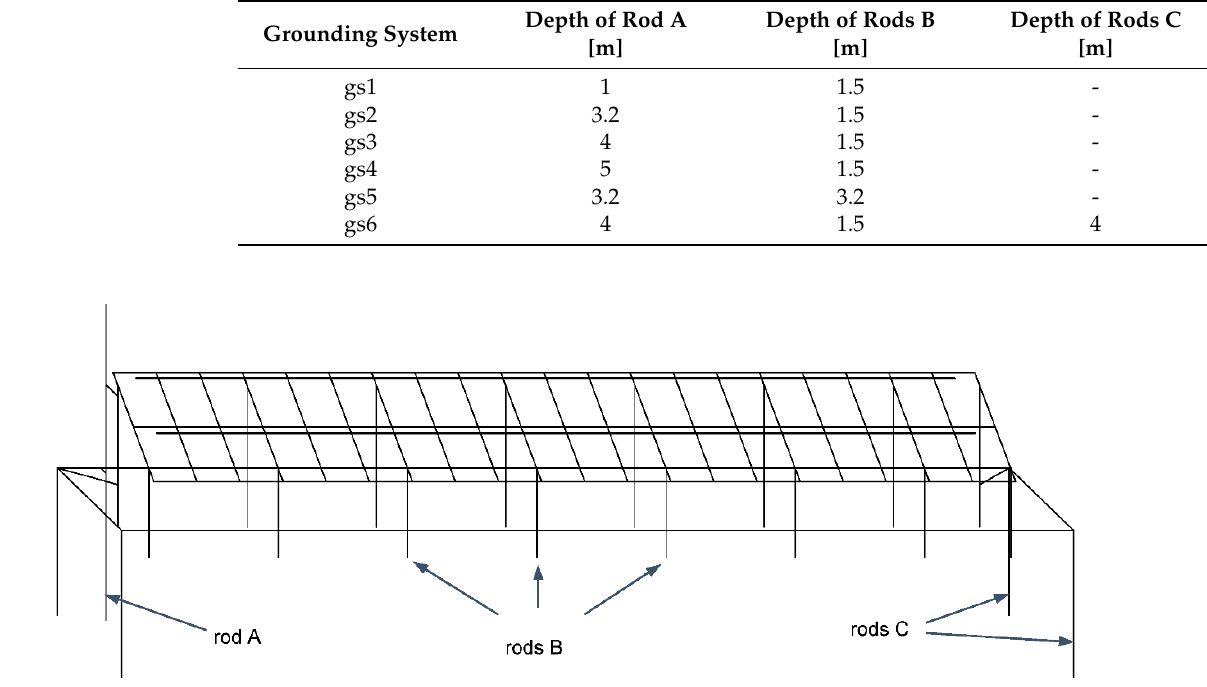
Figure 9. 3d simulation model indicating the structure of the examined grounding systems. Table 2. Examined grounding systems (gs) characteristics (see Figure 9 for rods A, B, and C).